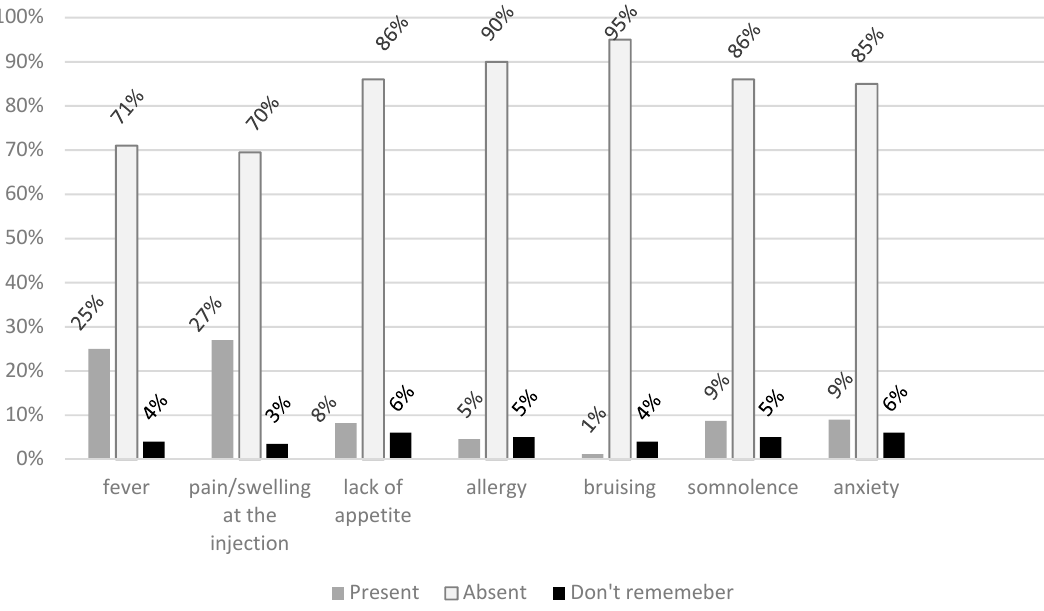
Figure 1. Frequency of particular reported AEFI in the question. Have your child / children ever had a post-vaccination reaction after immunization? If yes, what were the symptoms? (multi-choice-